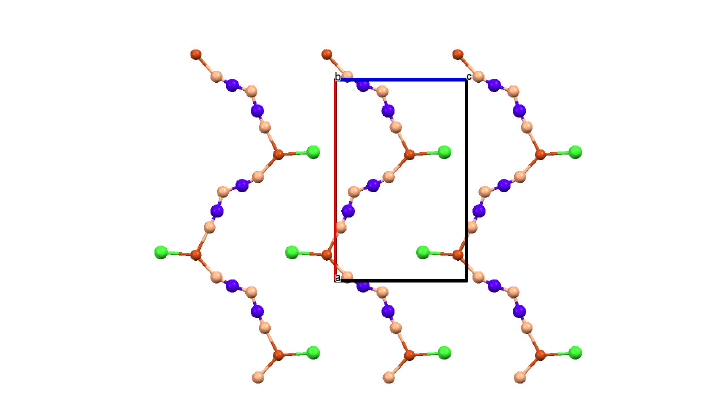
Figure 8. View of the anion layer of κ -Cl in the ac plane projected along the b -axis. Copper is colored in red, and chlorine in green. Carbon and nitrogen are colored in blue and orange, respectively. The unit cell is marked as a